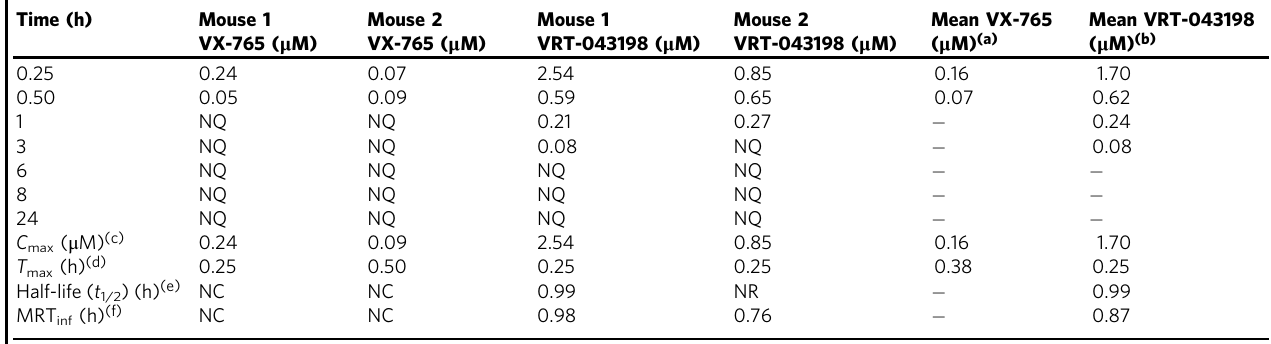
Table 2 VX-765 and VRT-043198 are detected in the brain after a single IP dose of VX-765. Time (h) Mouse 1 VX-765 ( μ M)